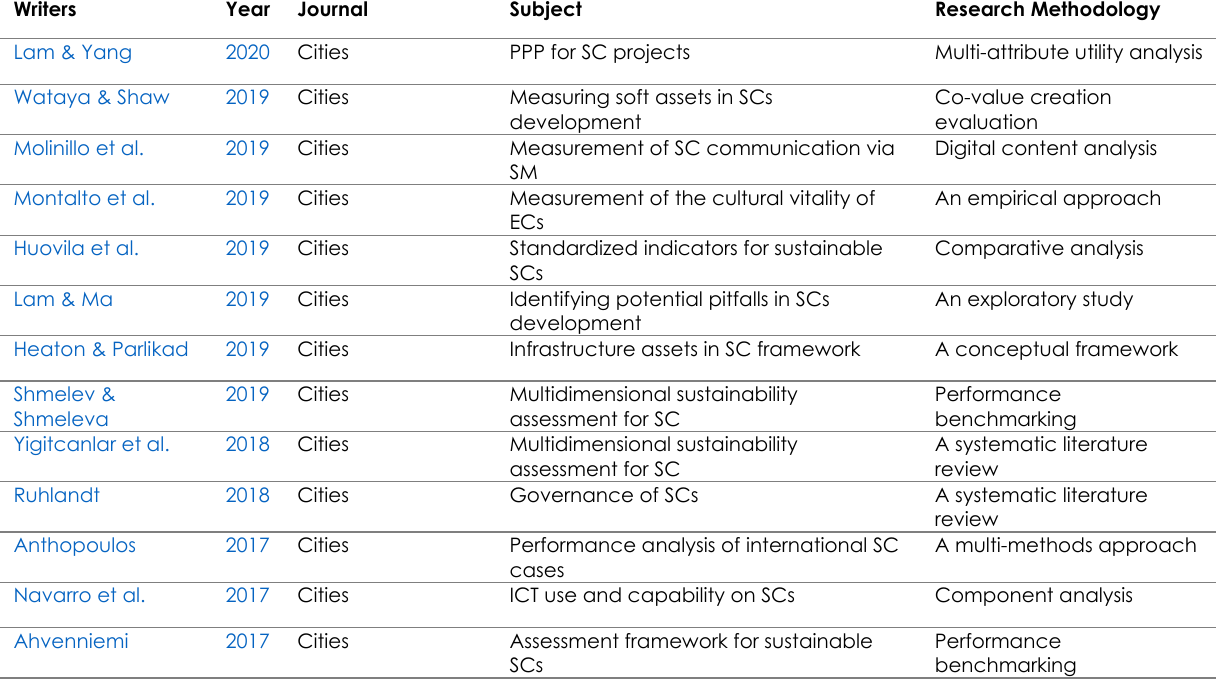
Table 1. Papers associated with KPIs of Smart City that have been issued in Urban Literature during